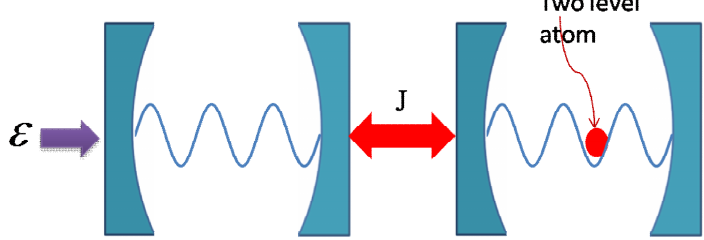
Figure 1. Schematic of the studied system. The system consists of two cavities, which are coupled to each other through a photon-hopping interaction. The first cavity is a linear cavity driven by a continuous laser. The second cavity is nonlinear with a two-level atom.